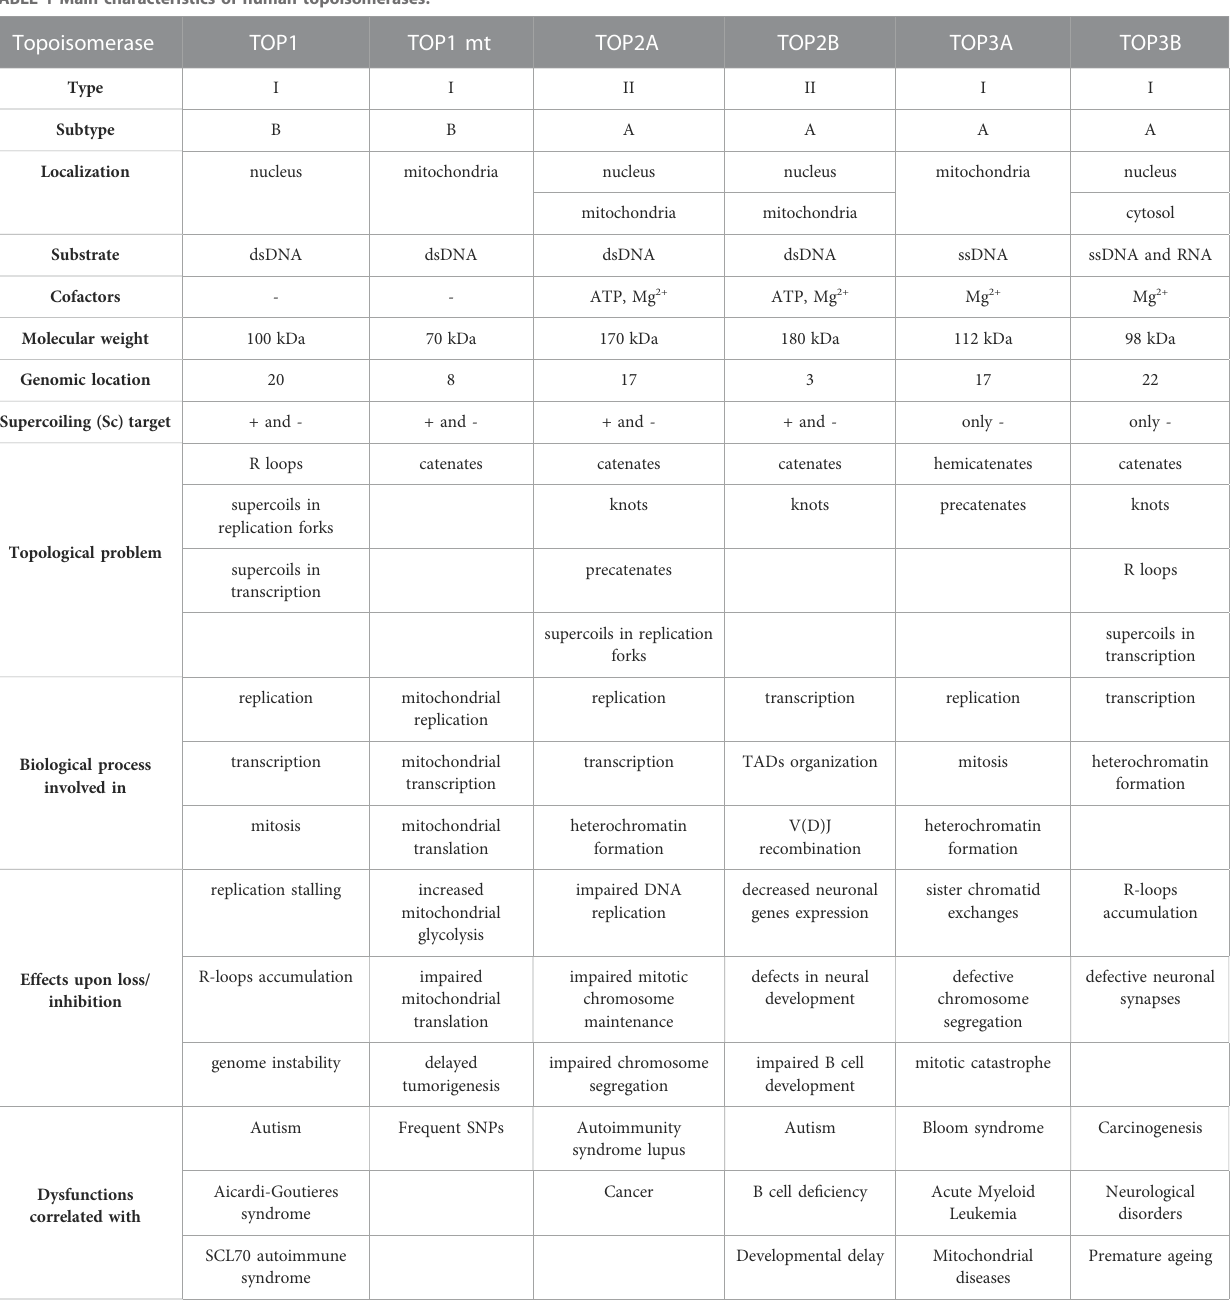
TABLE 1 Main characteristics of human topoisomerases.